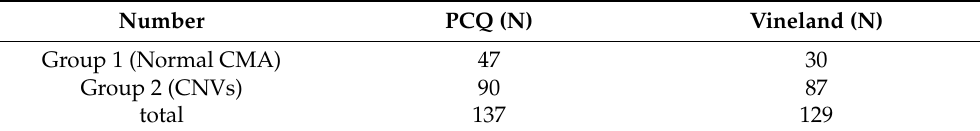
Table 1. Number of Autism Subjects with Questionnaires per Experimental and Control Groups.